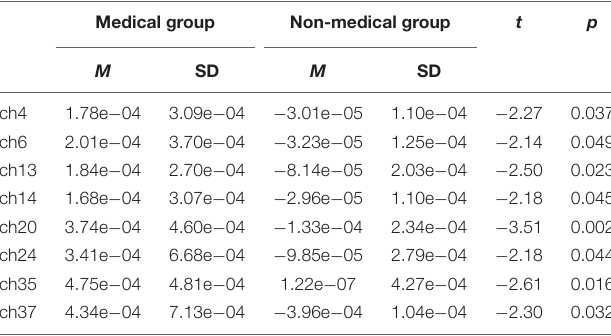
TABLE 3 | Comparison of the β value for each channel between the medical and non-medical groups.